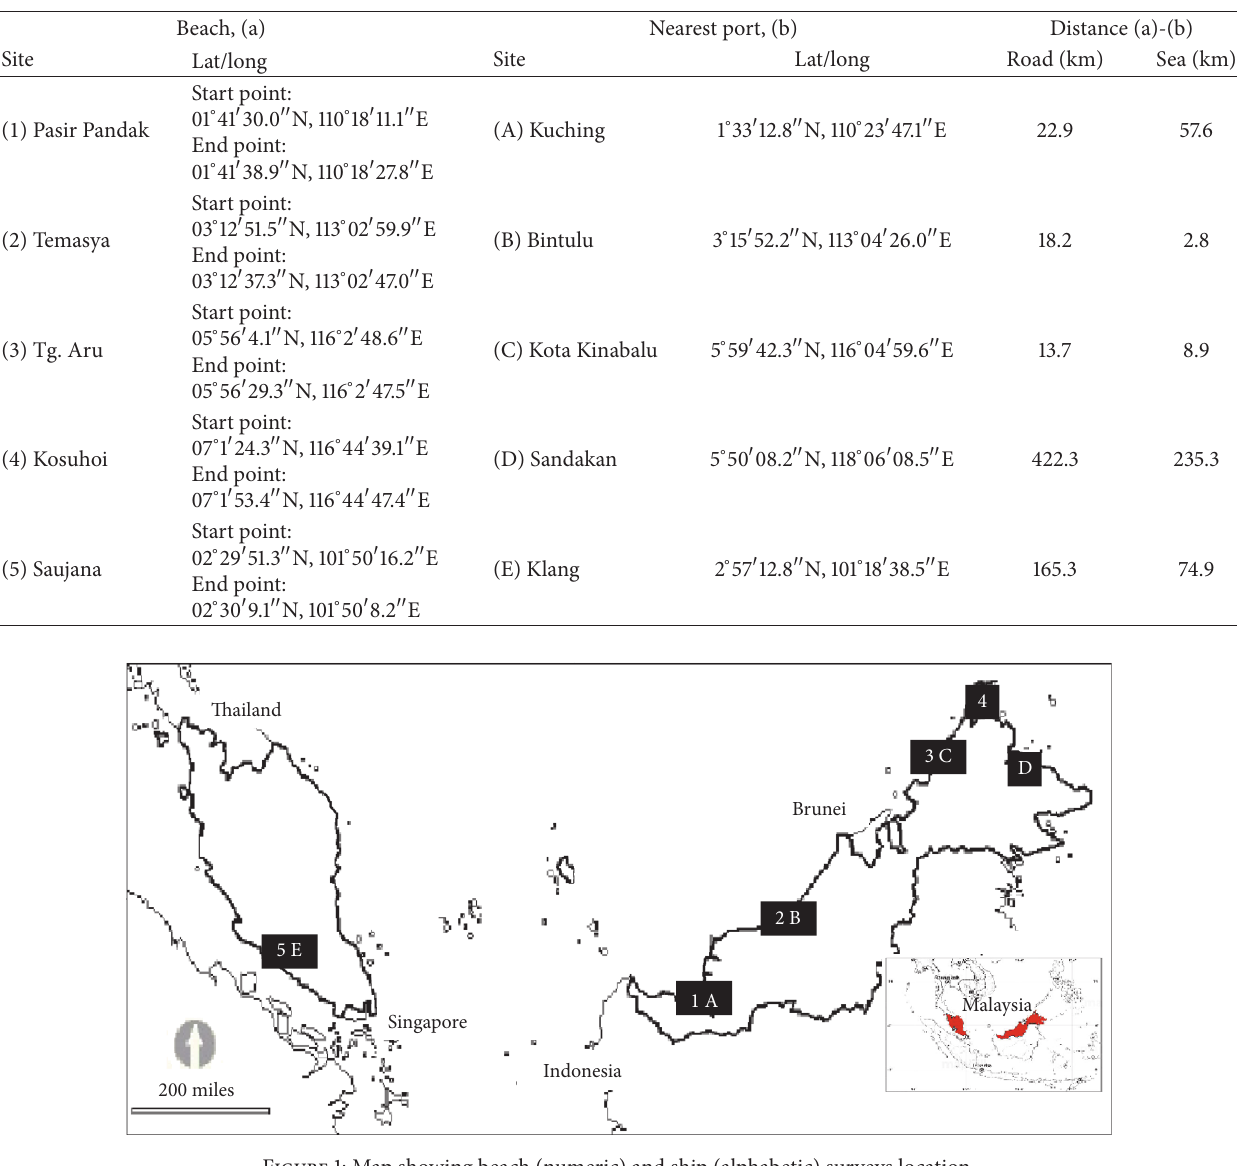
Figure 1: Map showing beach (numeric) and ship (alphabetic) surveys